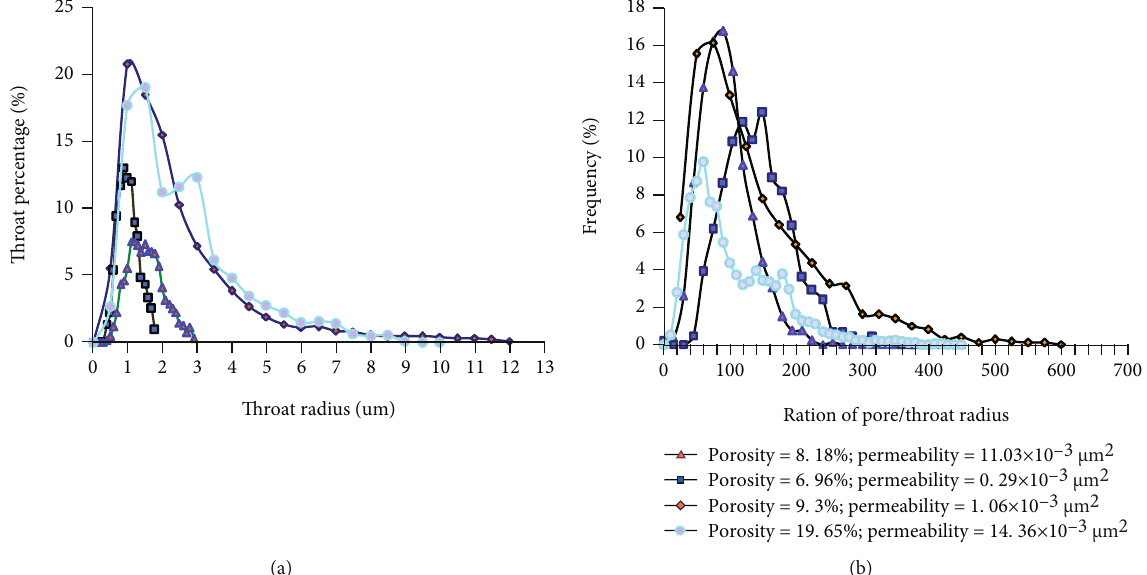
Figure 11: Distribution of throat radius and ratio of pore-throat radius for tight sandstones of di ff erent porosity-permeability